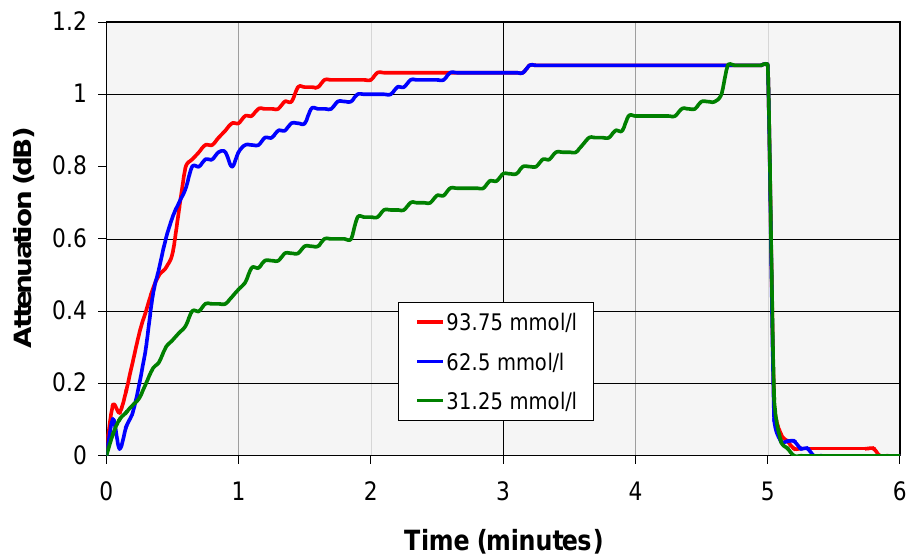
Figure 9. Response of the sensor when exposed to three different concentrations of methanol.